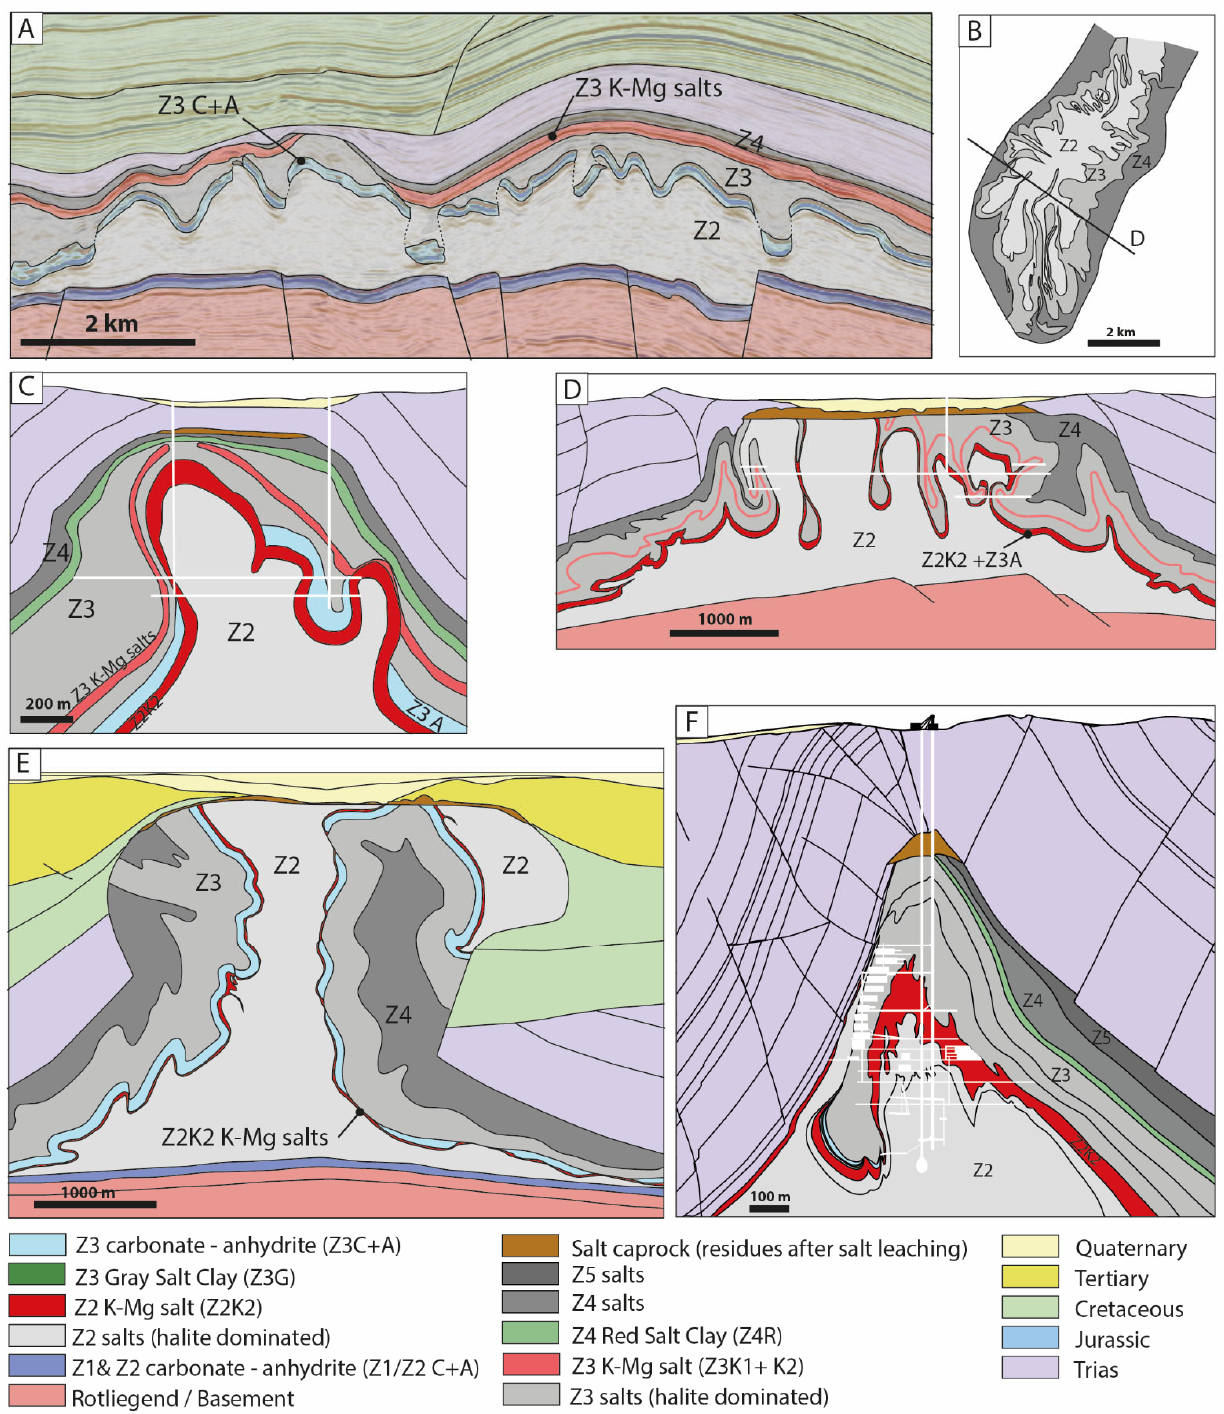
Figure 13. ( A ): Seismic cross section and interpretation (5× exaggerated) of salt pillows in onshore Netherlands (modified from [101]). Seismic interpretation is based on [31,101] works. ( A ) to ( F ): Illustration of internal structures constrained by subsurface mine data in German diapirs formed by the Zechstein salts and for which the core area is composed by the Z2. ( B ): Horizontal sections of the Benthe salt dome at a depth of 600 m below the surface (after [104]). ( C ): Cross section of the Salzdetfurth mine (after [111]). ( D ) : Cross section of the Benthe salt dome (after [112]). ( E ): Cross ‐ section of the Gorleben salt dome (from [113]). ( F ): Cross ‐ section of the Asse salt anticline (after [114,115]).